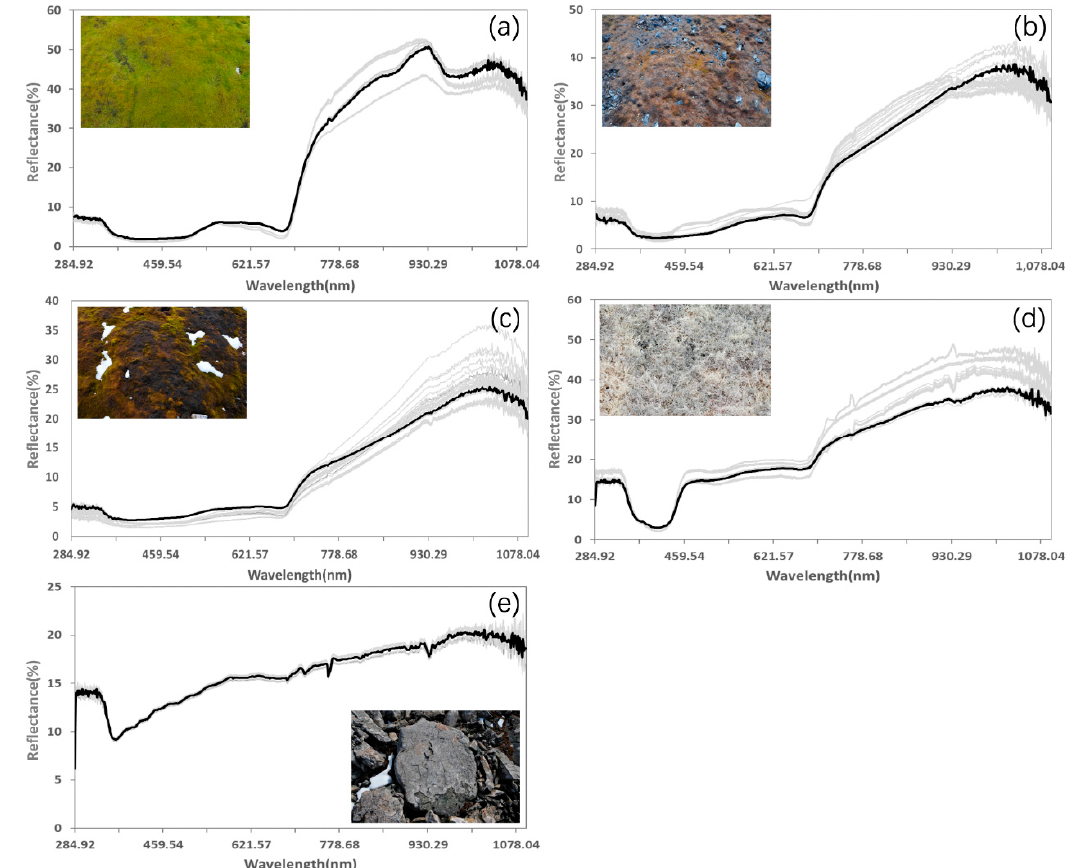
Figure 5. Spectral profiles for typical ground features in the study area, including ( a ) healthy mosses, ( b ) stressed mosses, ( c ) moribund mosses, ( d ) lichens, and ( e ) rocks. Bold lines denote the averaged spectral signatures.